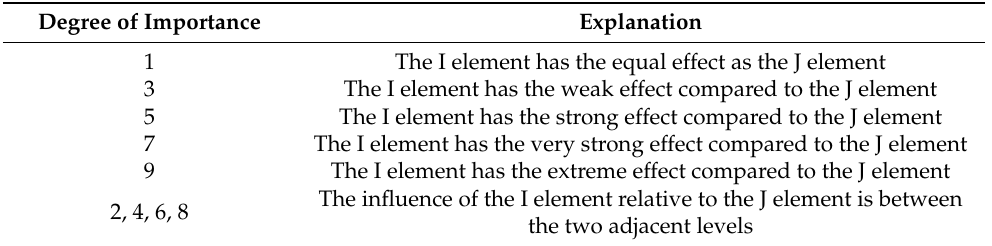
Table A1. Explanation of the pair-wise comparison scale.